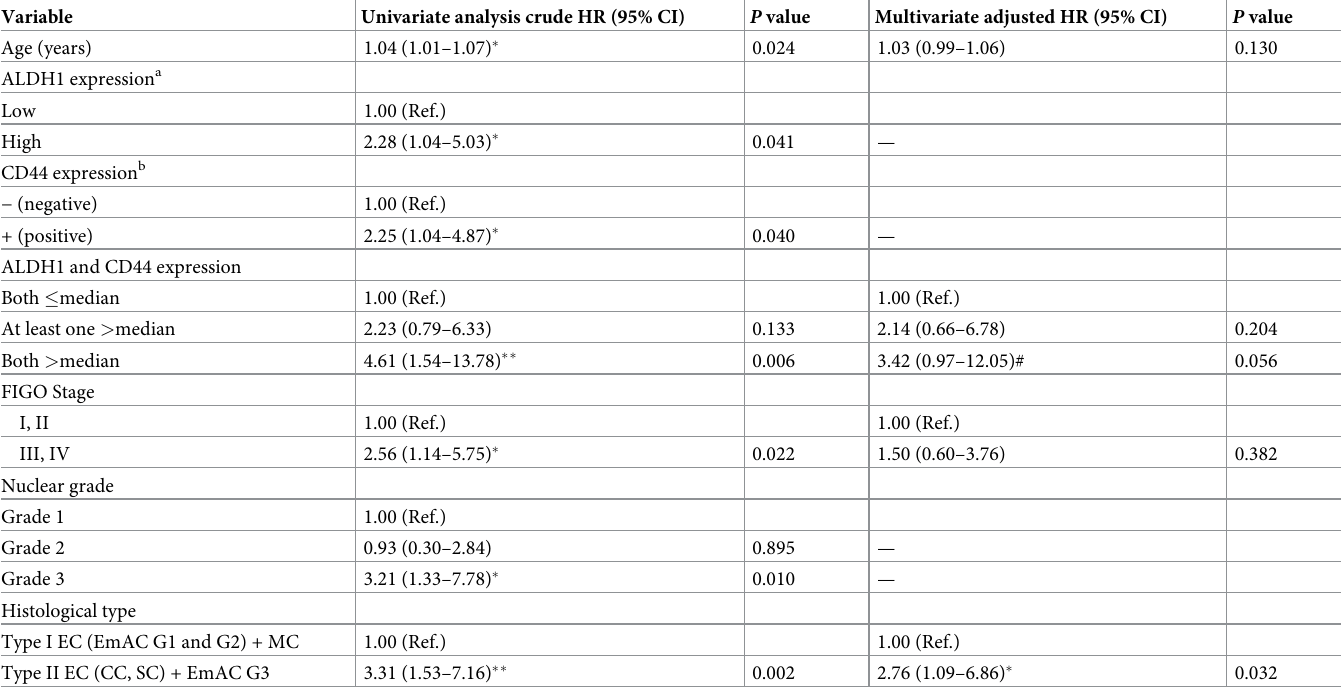
Table 4. Multivariate survival analysis of clinicopathological factors in 92 EC